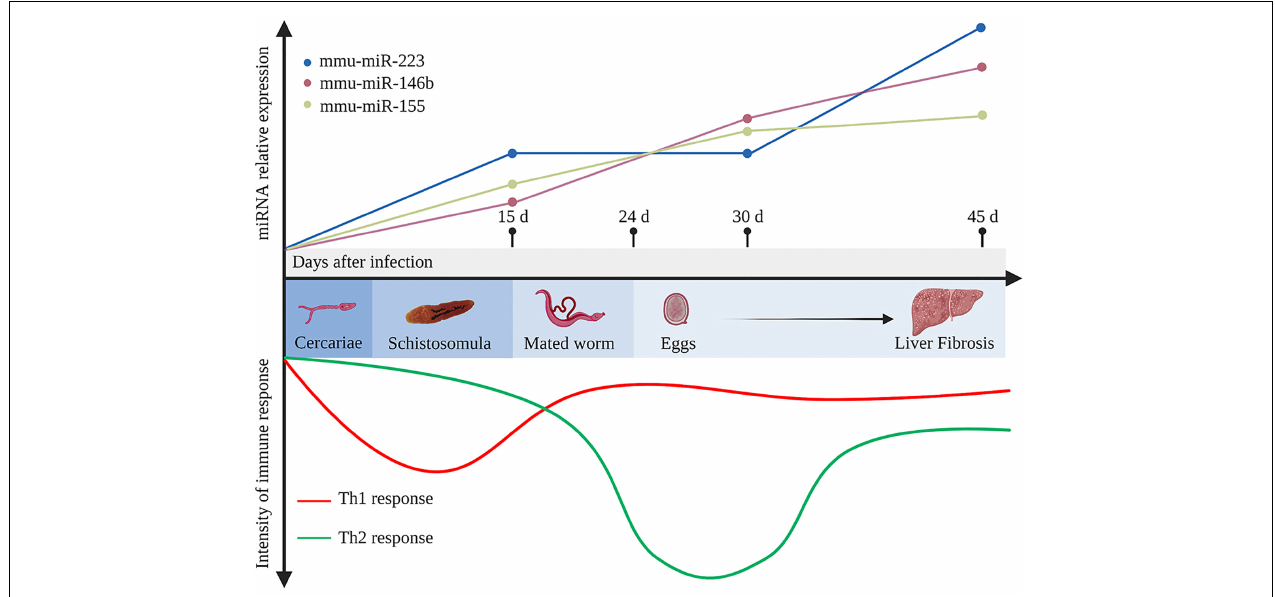
FIGURE 1 | Development of the immune response and representative differentially expressed host miRNAs during Schistosoma japonicum infection. In the early stage of infection, the host produces a T helper type 1 (Th1) response against the migrating immature schistosomula (about 15 days after infection). After the mated worms lay eggs (about 24 days after infection), which further secrete antigens that stimulate the body to generate a strong Th2 response. Ultimately, when the disease develops into the chronic liver fibrosis, the Th2 response is diminished but still dominant. During infection, mmu-miR-223, mmu-miR-146b, and mmu-miR-155 in the liver tissues continuously elevated at 15, 30, 45 days after infection (Cai et al., 2013b). d, days. This figure was created with Biorender.com.